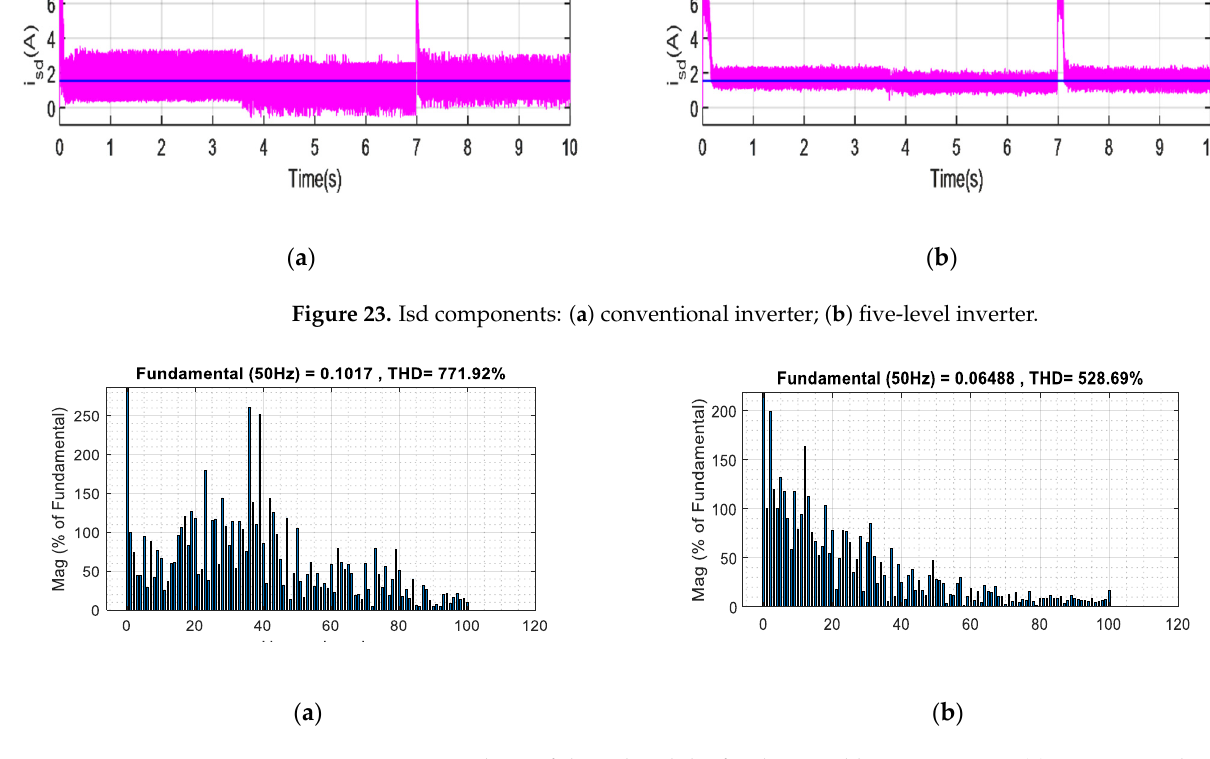
Figure 24. FFT analysis of the Isd and the fundamental harmonic THD : ( a ) conventional inverter; ( b ) five-level inverter. Table 5. Δ Isd and Δ Isd of two- and five-level inverters.